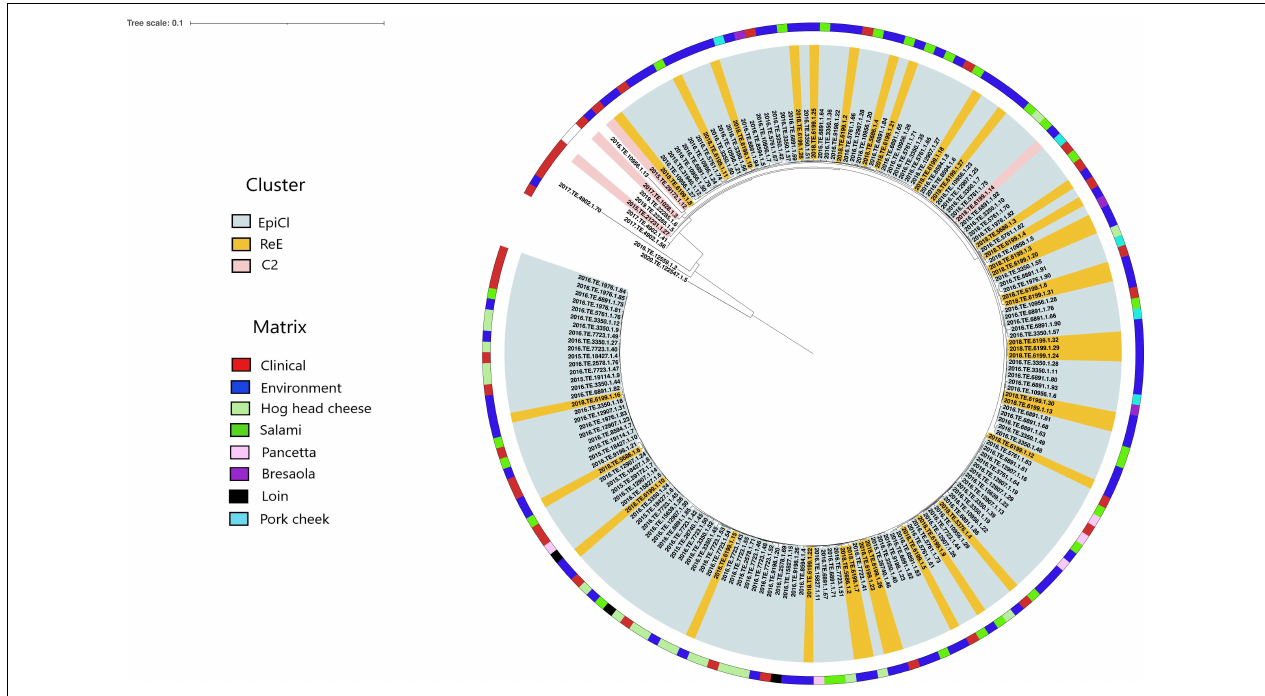
FIGURE 2 | Maximum likelihood (ML) tree obtained from the single-nucleotide polymorphism (SNP) analysis. The ranges are colored according with the cluster, and the first layer represents the source of isolation as shown in the legend. The ML tree was midpoint